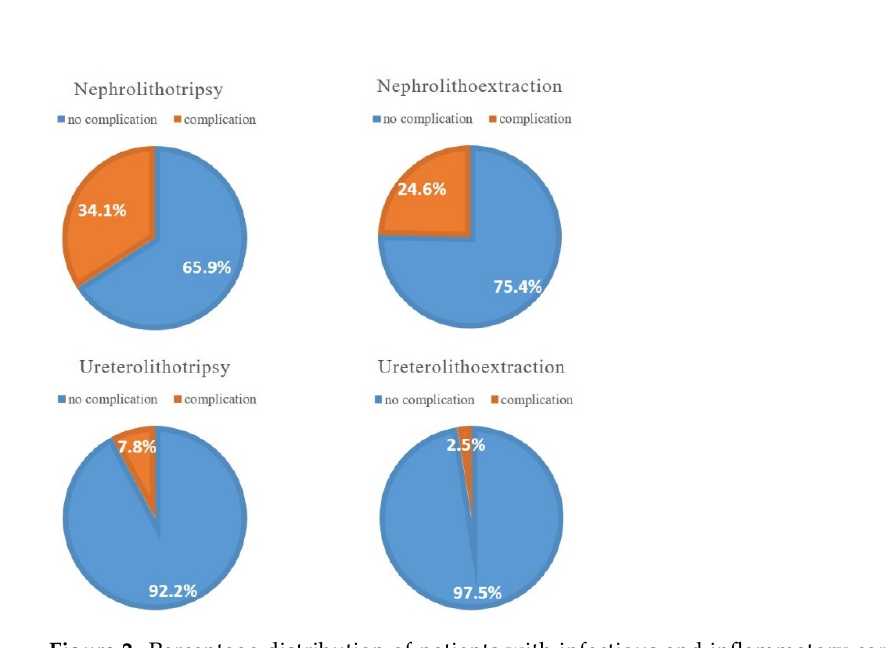
Figure 2. Percentage distribution of patients with infectious and inflammatory complications oc- curred in the postoperative period, and without them, depending on the type of endoscopic treatment of urolithiasis.